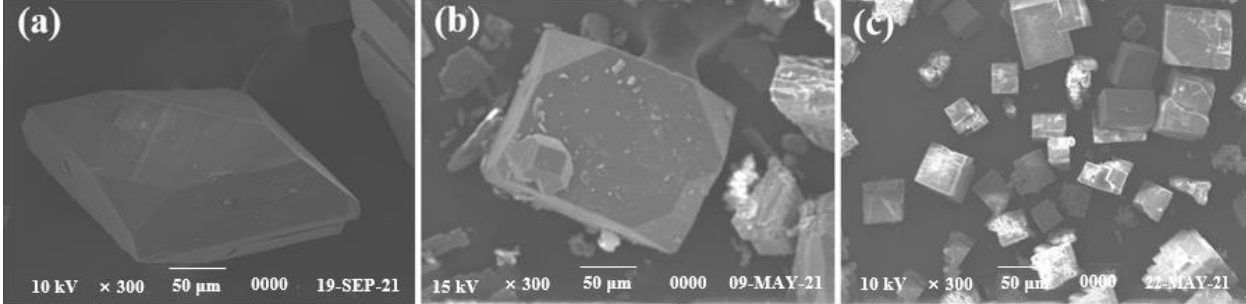
Figure 2. SEM images of MOF-5 prepared at a hydrothermal temperature of 140 °C at 300 times magnification when the mass ratios of Zn (NO 3 ) 2 ·6H 2 O/H 2 BDC are 1:1 ( a ), 1:0.5 ( b ) and 1:0.3 ( c ) .